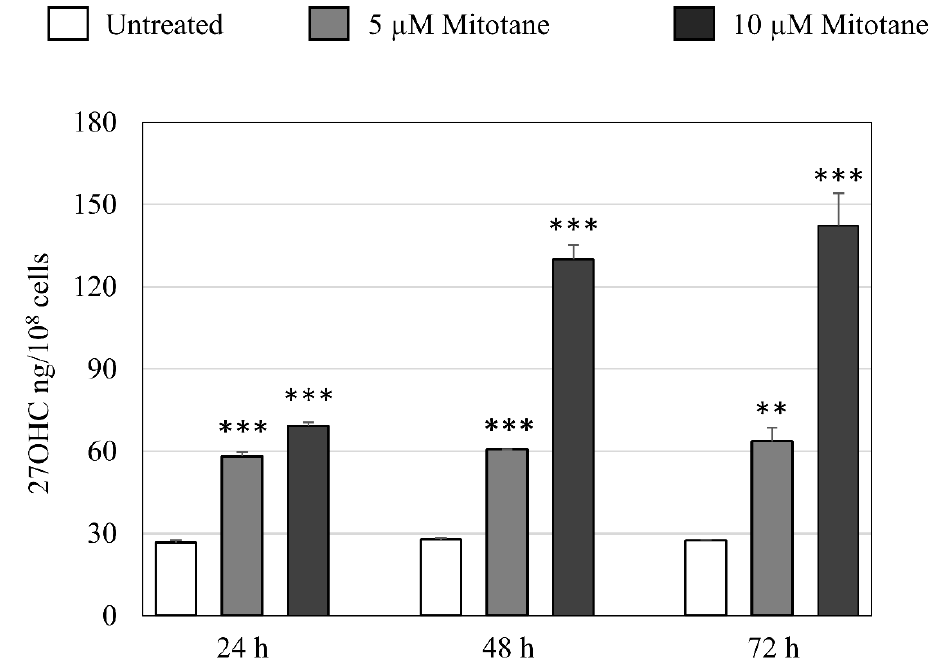
Figure 1. Production of 27-Hydroxycholesterol by H295R cell treatment with mitotane. H295R cells were incubated at 37 ◦ C up to 72 h, in the absence or in the presence of two di ff erent concentrations of mitotane, namely 5 and 10 µ M. Data are reported as means ± SD from three independent experiments, after normalization for the cell number, and are expressed in ng / 10 8 cells. Significantly di ff erent versus untreated cells: ** p < 0.01; *** p <